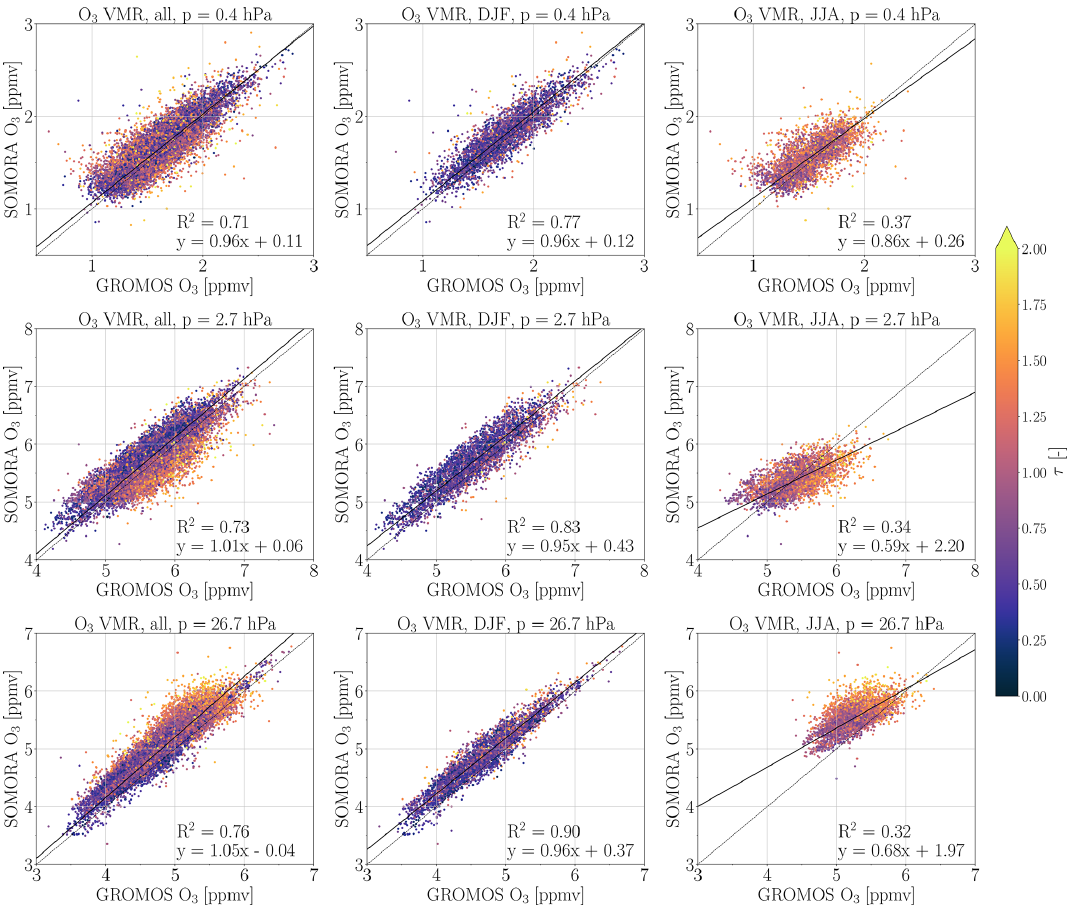
Figure 8. Mean ozone VMR for three different levels for the whole series (left column), the boreal winter season (middle column) and the boreal summer (right column). The three pressure levels correspond approximately to the lower stratosphere (10 < p < 50hPa), upper stratosphere (1 < p < 5hPa) and lower mesosphere (0 . 1 < p < 0 . 9hPa). All data points are colour coded based on the atmospheric opacity ( τ ) computed at SOMORA measurement time and location. The linear regression coefficients and their coefficient of determination R 2 are indicated on each